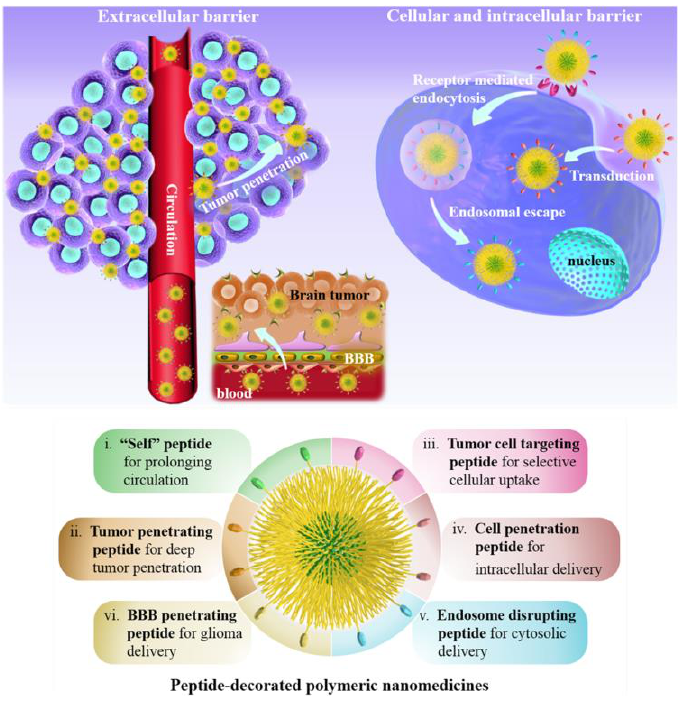
Figure 3. Mechanisms of peptide-decorated polymeric nanomedicines in the blood stream, brain tumor therapy, and cellular and intracellular environments. Reproduced with permission from Sun et al. (2018) [138] , © Elsevier, 2018.